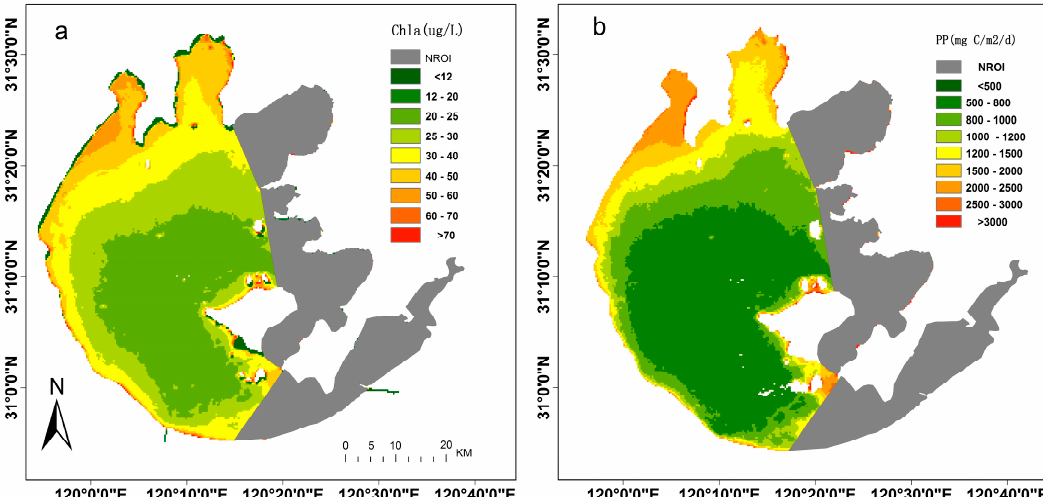
Figure 9. ( a ) Chl a distribution in Lake Taihu averaged from all Chl a estimates from the MODIS data gathered from 2003–2013 and ( b ) spatial PP distribution in Lake Taihu based on all PP estimates from the MODIS data gathered from 2003–2013.